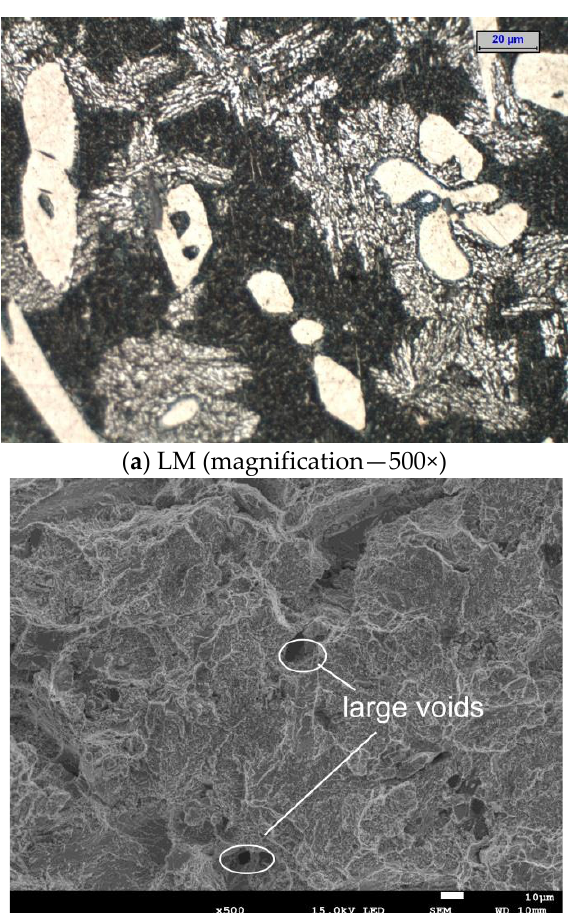
Figure 13. SEM image of fracture surface after tensile test (at 750 ◦ C and 900 ◦ C) and prior isothermal holding at 750 ◦ C for 1 h ( a , e , g ) and at 900 ◦ C for 1 h ( b , f , h ); LM microstructure from tensile specimen ( c , d ); images ( e , f , g , h ) from the frame area.